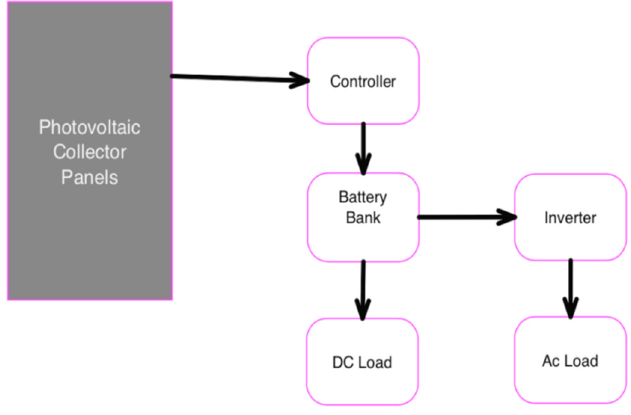
Figure 6. Schematic diagram for a stand-alone solar power system.